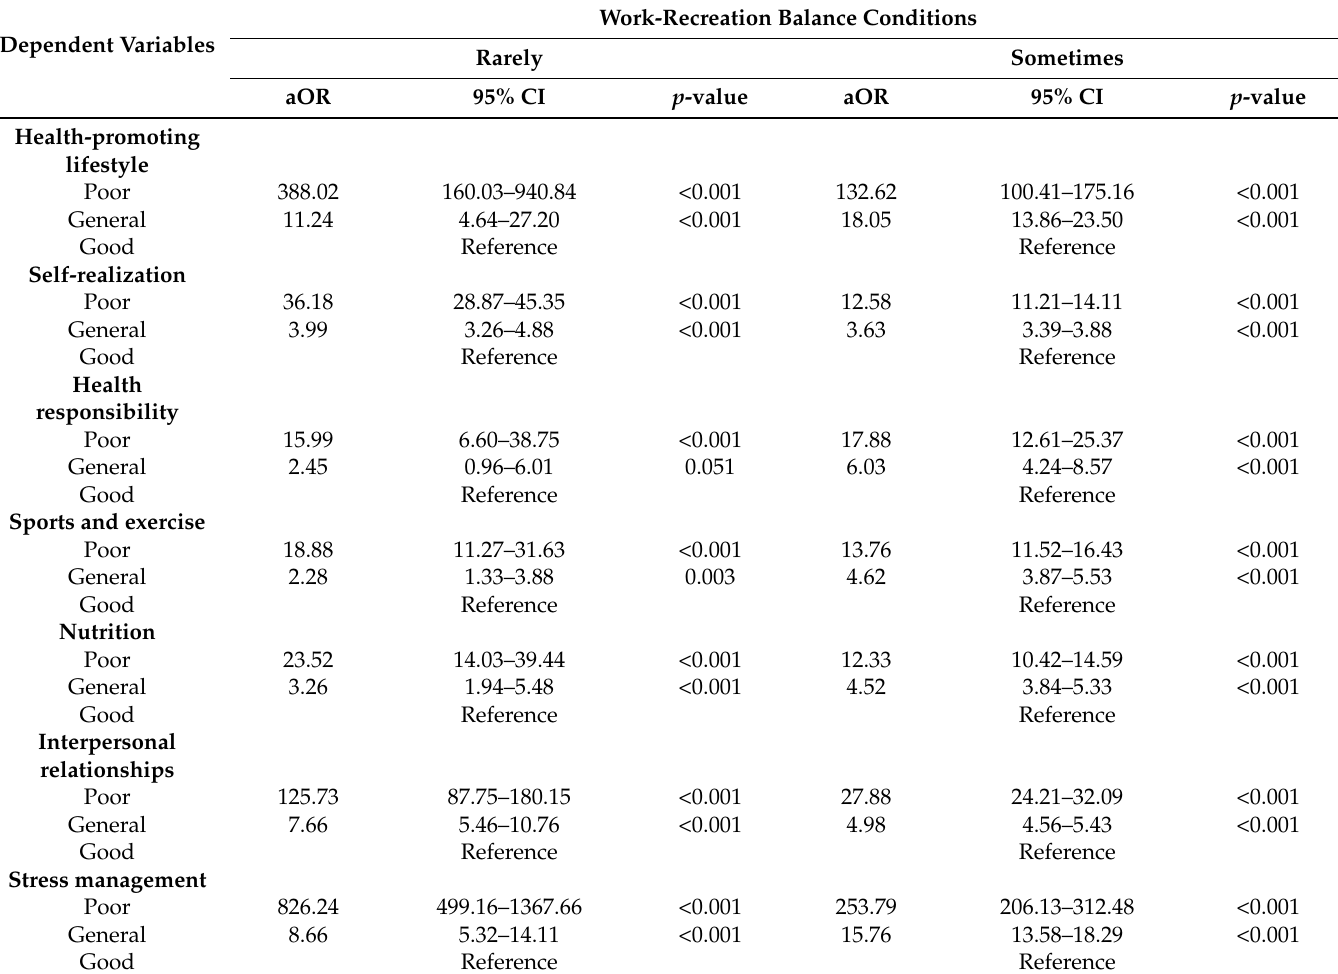
Table 4. Work-recreation balance frequency and health-promoting